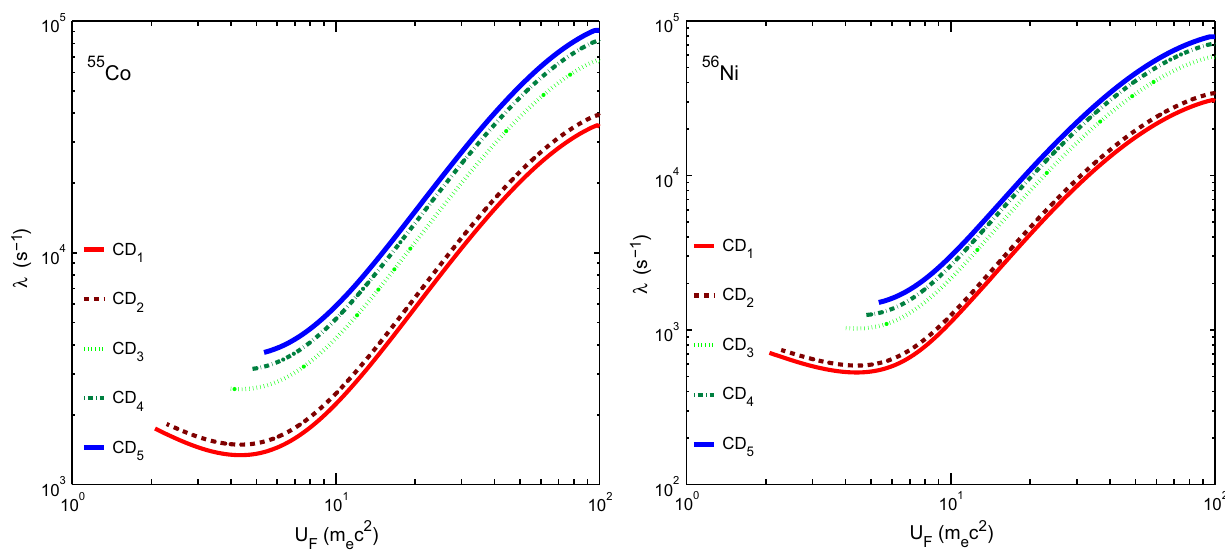
= 6 . 63 , Y = 0 . 46 , T = 3 . 51; ρ = 11 . 7 , Y = 0 . 45 , T = 3 . 73; ρ e e 7 9 7 9